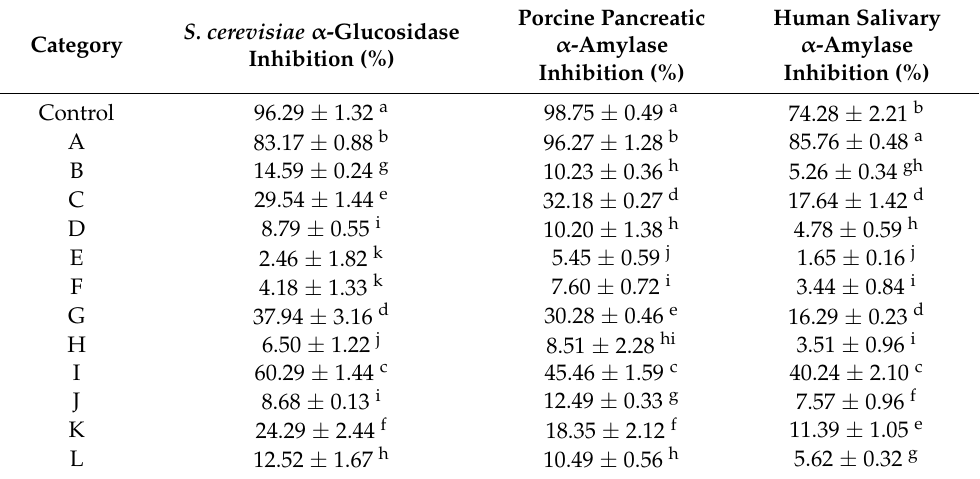
Table 3. The inhibitory activity of seven plant materials of the Polygonaceae family and grape seed